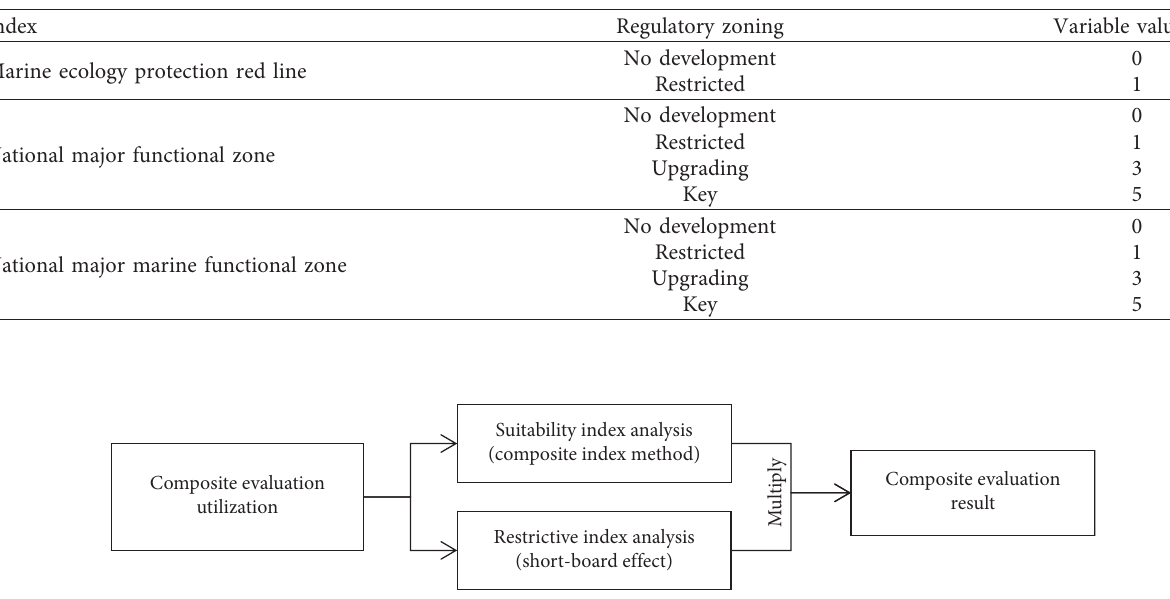
Figure 1: Basic principle of the improved restrictive composite index